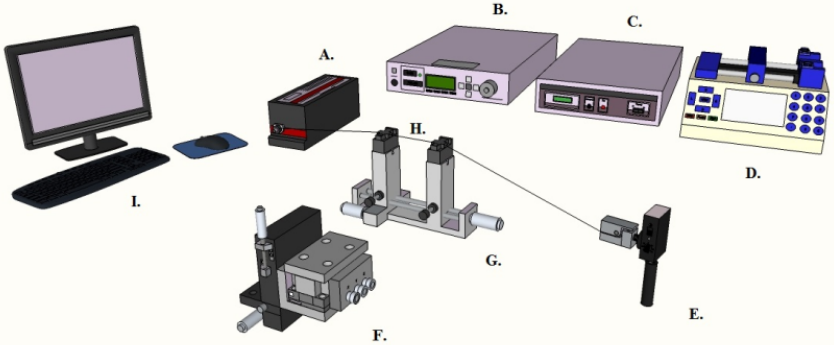
Figure 2. A model for the experimental setup used to determine the Q factors of the microspheres.